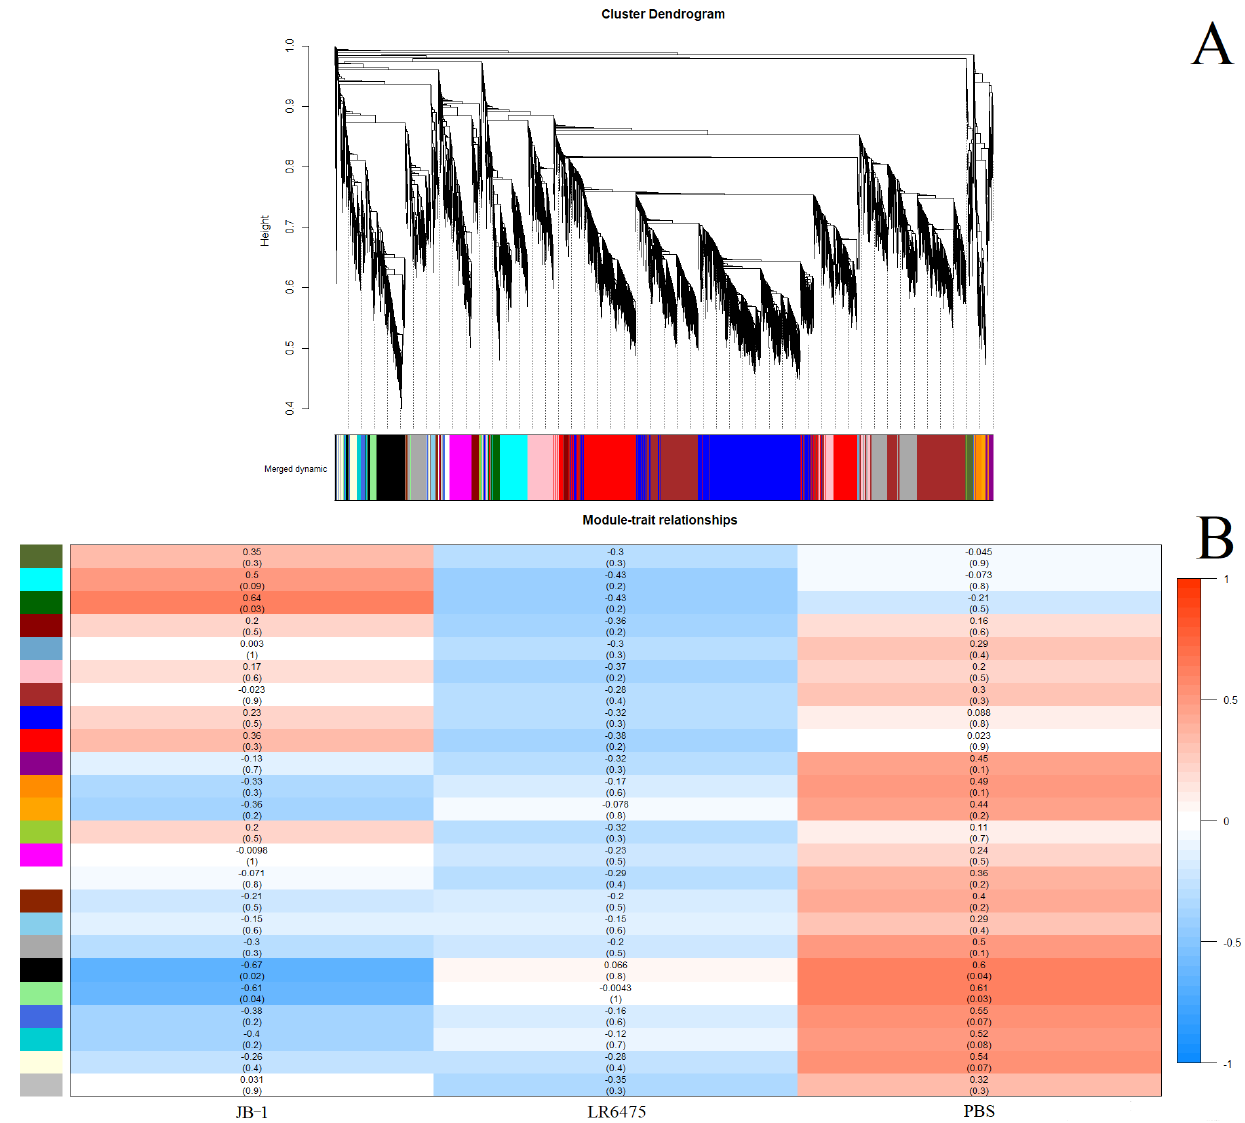
Figure 3. Weighted correlation network analysis (WGCNA) of blood mRNA from mice fed one of JB-1, LR6475, or PBS. ( A ) Unsupervised cluster dendogram of commonly co-expressed genes shown grouped into modules by colour. ( B ) Gene module and feed group relationships shown in a heatmap with relative expression level and p -value in brackets under it for each relationship.